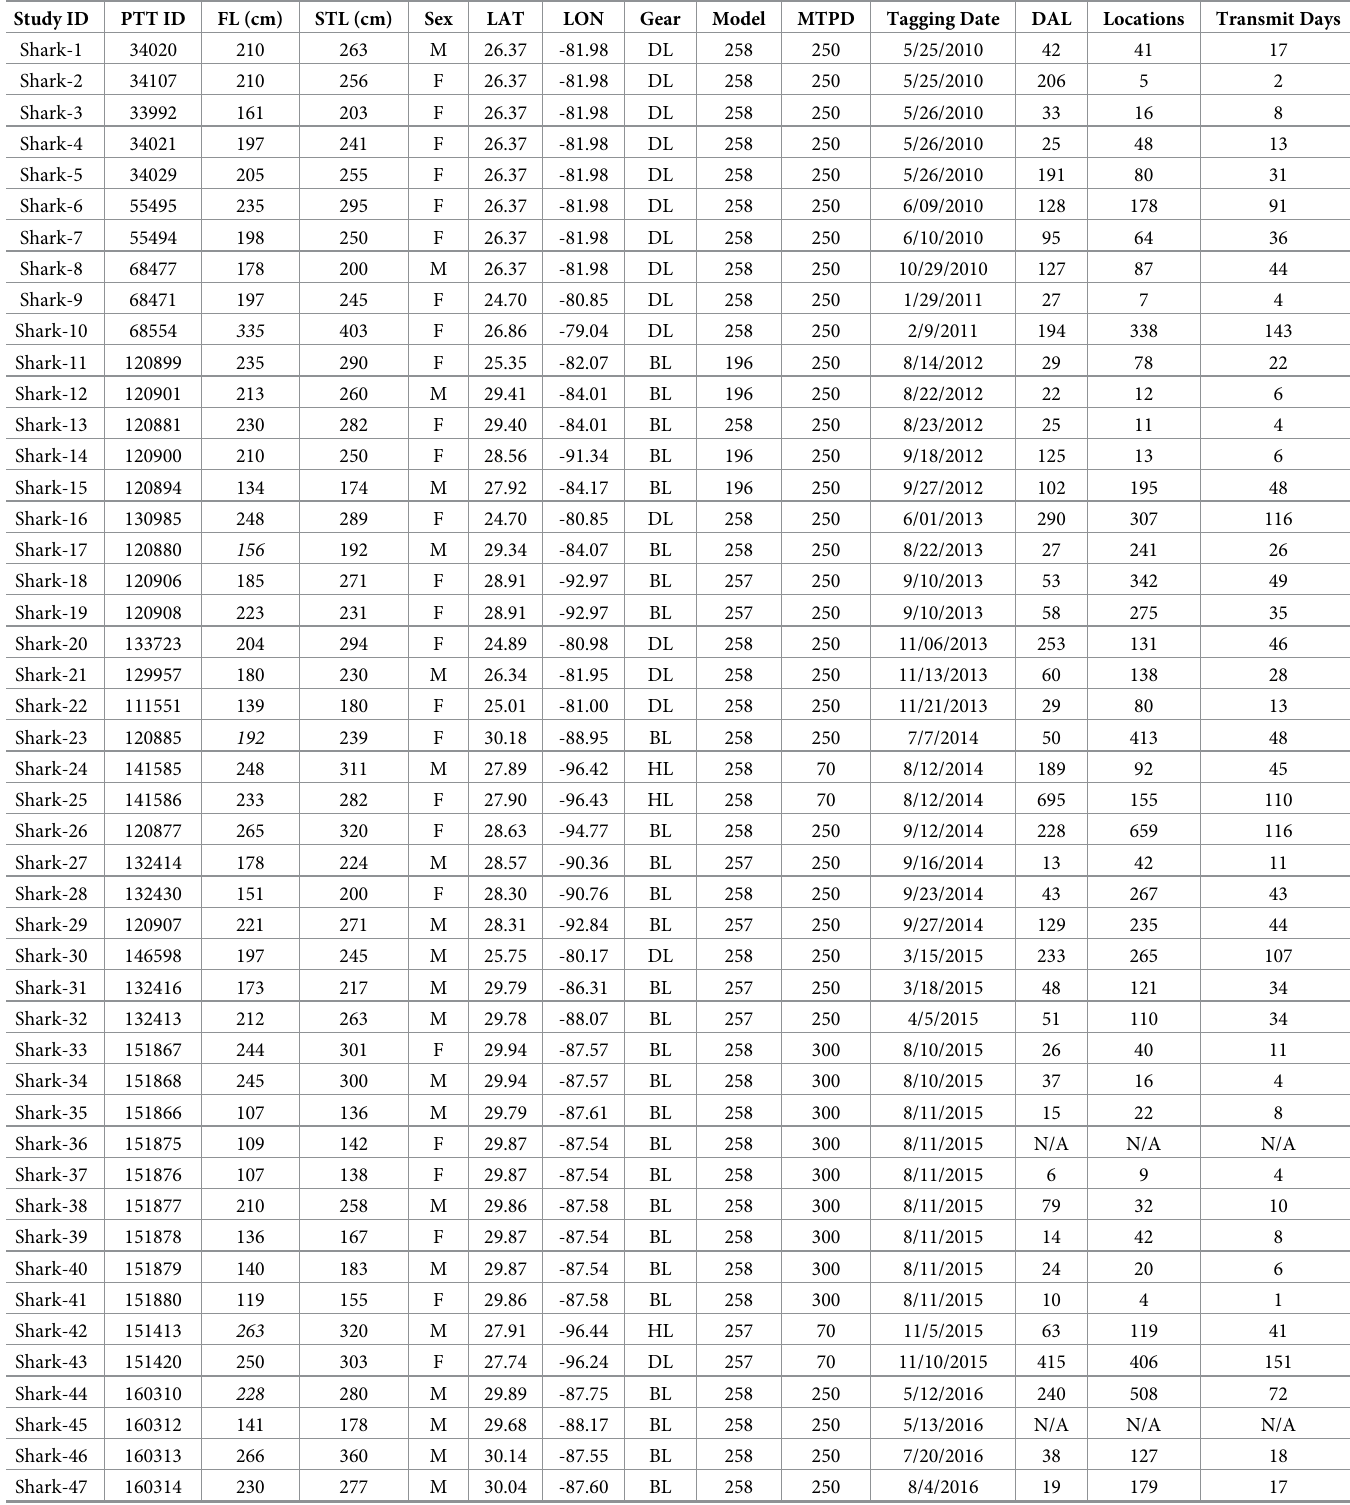
Table 1. Collection information and tag performance of individuals tagged in